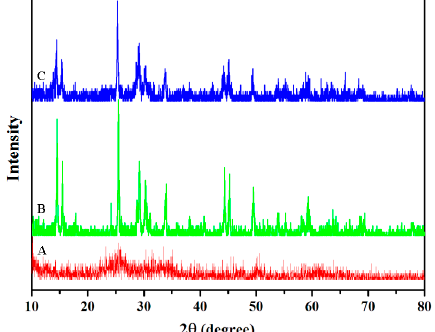
Figure 2. XRD patterns of VO 2 nanoparticles. (A) VO 2 nanofiber; (B) VO 2 nanosheets; (C) VO 2 nanorods.